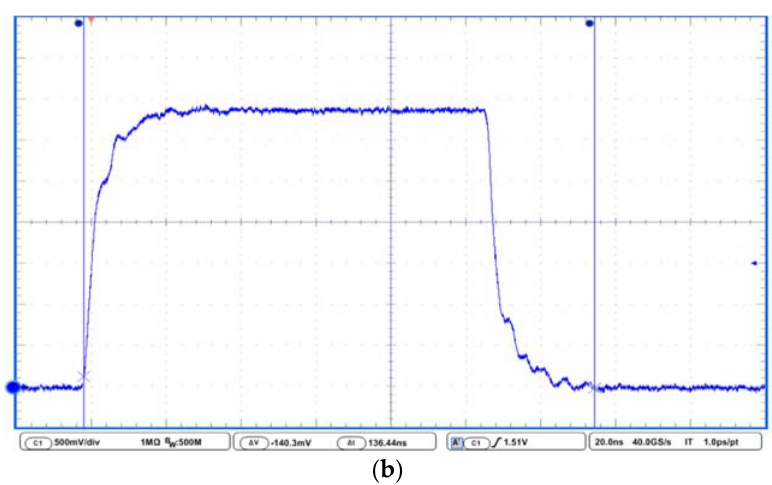
Figure 10. Oscilloscope measurements of the GPIO pin for the configuration F of Table 3 in the case of FPGA implementation. ( a ) Measurement of the execution time of the Forney algorithm. ( b ) Measurement of the execution time of the Lu method.